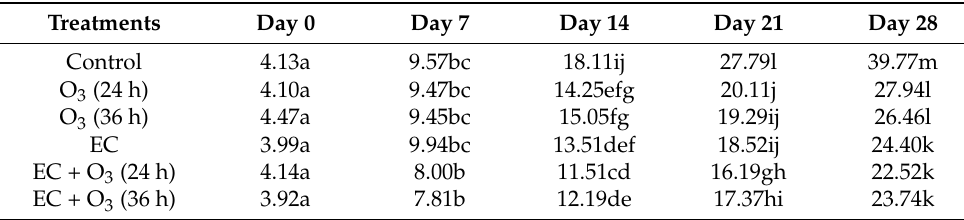
Table 1. Effect of edible coating (EC) and gaseous ozone (O 3 ) on relative electrolyte leakage (REL) (%) of mango fruit during storage for twenty-one days at 10 ◦ C and shelf-life for seven days at ambient temperature. Data represent means (LSD = 2.00, n =